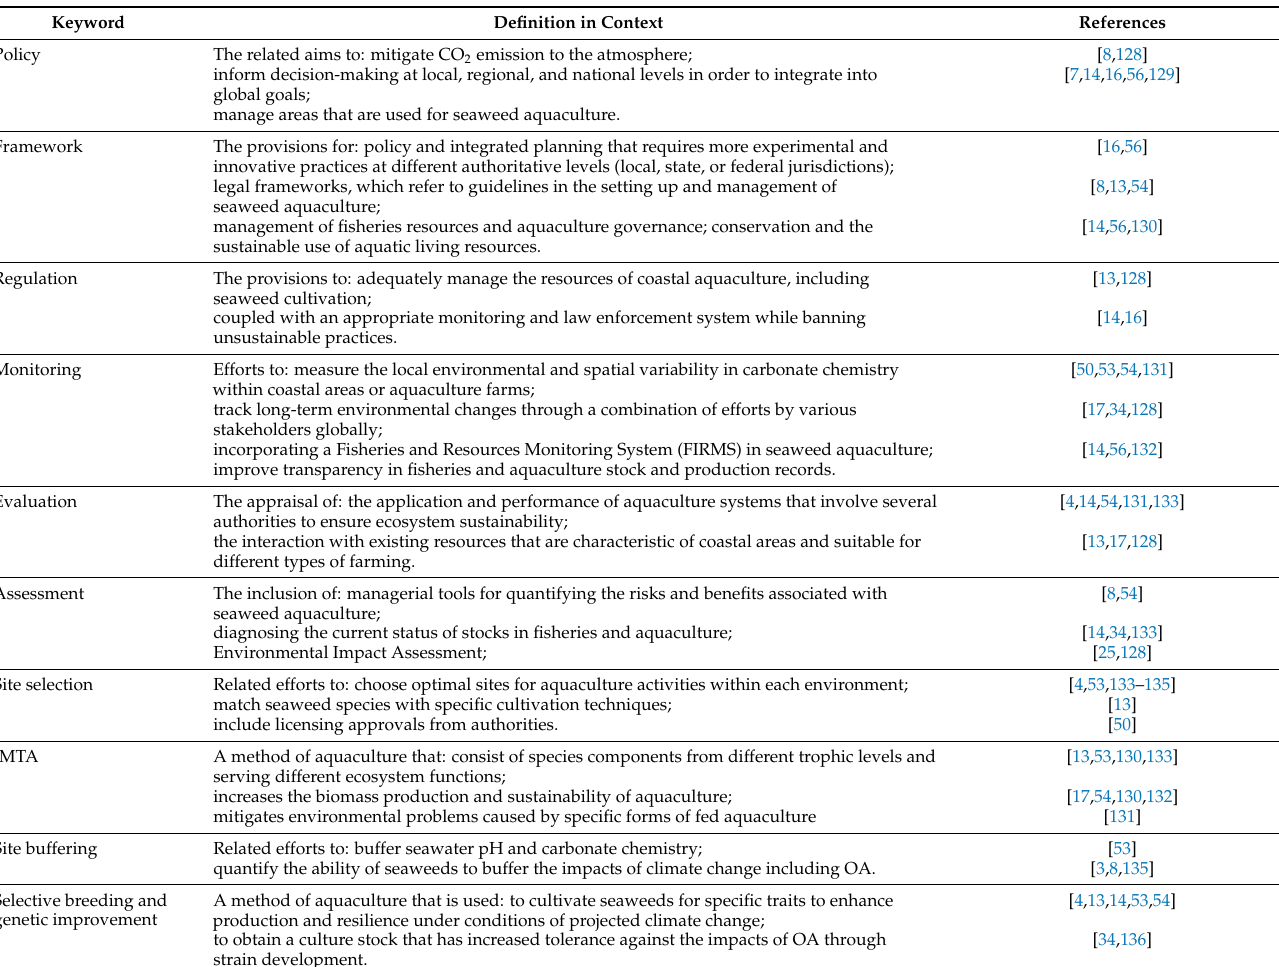
Table 2. Definition of the terms used in the radar chart, with the selection of words based on the applied contextual meaning to avoid duplication in occurrence counts and their use being overlooked during the keyword